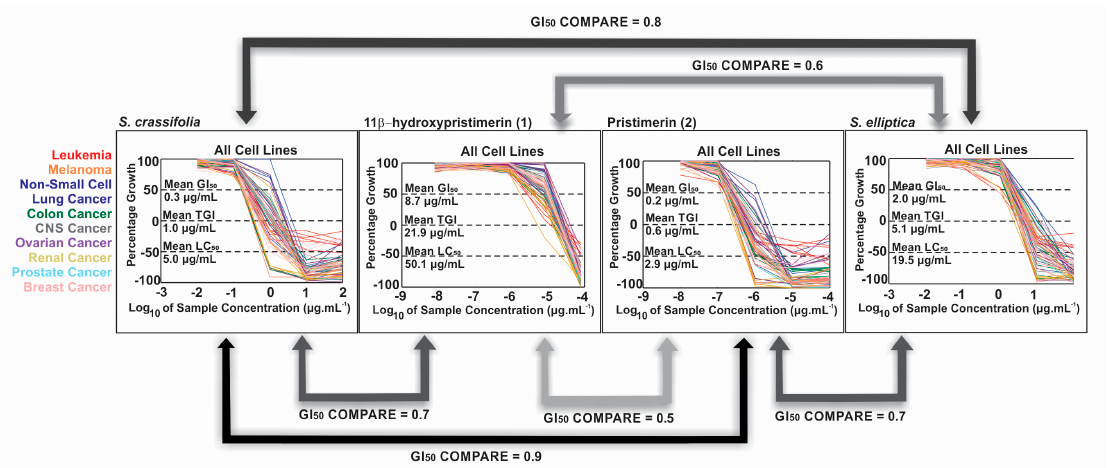
Figure 4. COMPARE correlations between 1 , 2 and Salacia extracts.